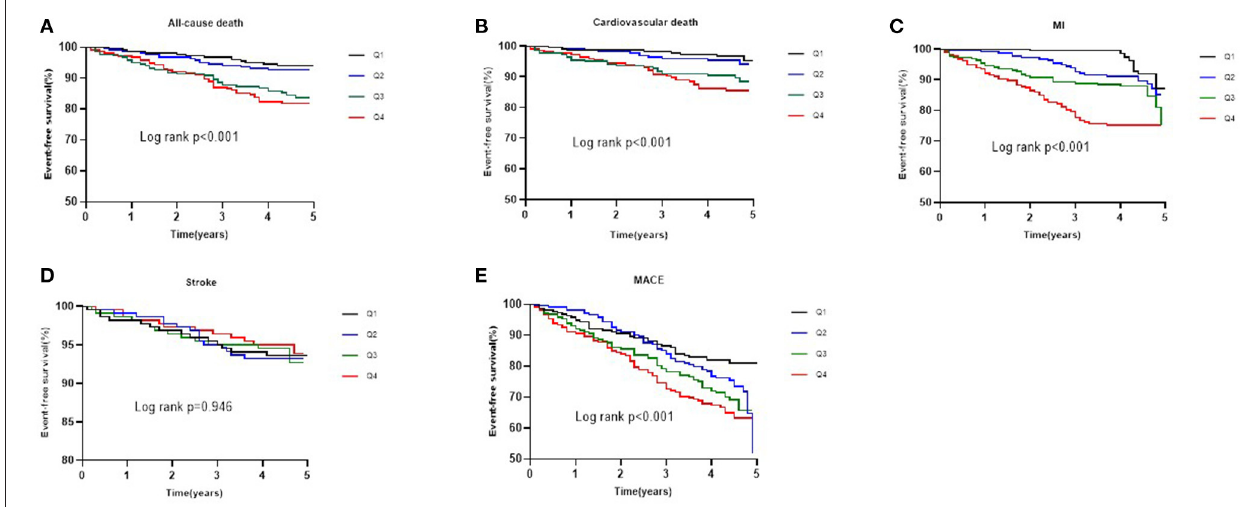
FIGURE 1 | Kaplan-Meier survival curve for all-cause death (A) , cardiovascular death (B) , MI (C) , stroke (D) , and MACE (E) across NT-proBNP quartiles.